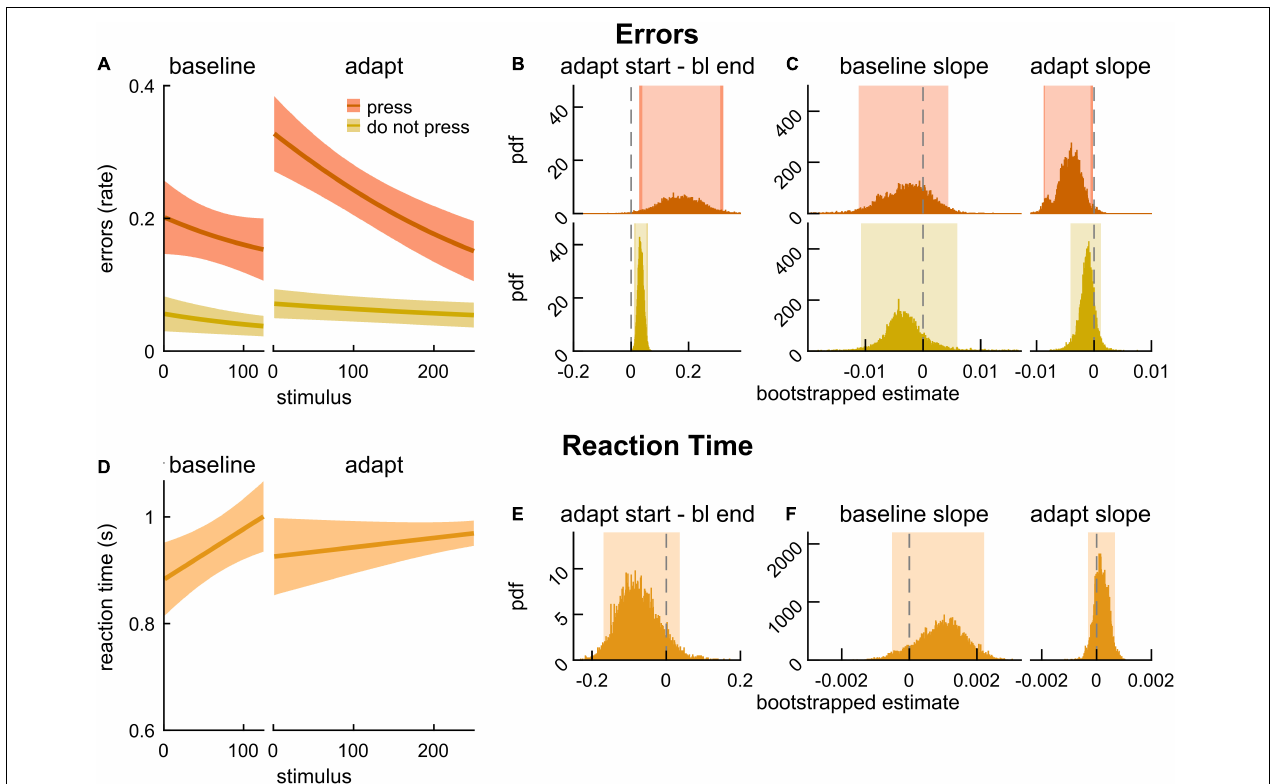
FIGURE 5 | 2-back performance during baseline walking and locomotor adaptation in late middle-aged adults. (A) Logistic fits (mean and shaded SE) of the error rate in response to press stimuli (dark orange) and do not press stimuli (yellow) during an auditory 2-back task. (B) PDF of the differences in error rate estimates between the start of adaptation (first value) and the end of baseline (last value) from logistic model fits. (C) PDF of slope estimates for logistic fits of error rate in baseline and adaptation. (D) Linear fits (mean and shaded SE) of reaction time. (E) PDF of the differences in reaction time estimates between the start of adaptation (first value) and end of baseline (last value) estimated from linear model fits. (F) PDF of slope estimates for linear fits of reaction time in baseline and adaptation. Lighter shaded areas of PDF plots indicate the 95% CI; when applicable, darker shaded areas of PDF plots indicate the correction to the CI for 3 comparisons. SEs, PDFs, and CIs were obtained through bootstrapping. Error rate with press and do not press stimuli declines with adaptation in late middle-aged adults, and error rate with press stimuli only improves throughout